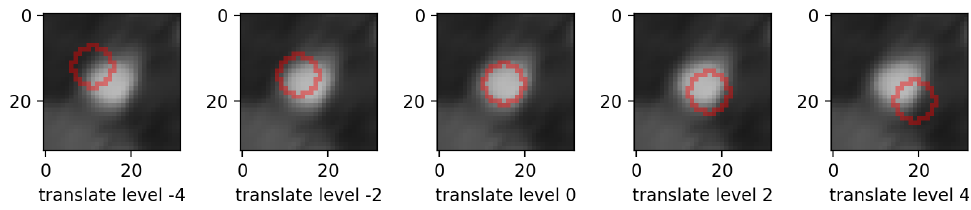
Figure 5. Example of mask translation perturbation in the topLeft-bottomRight direction. Only the mask contour is